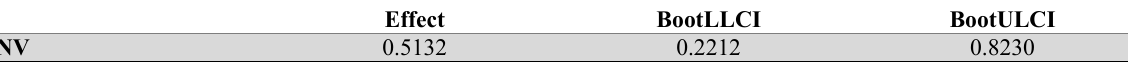
The direct impact of environmental concerns